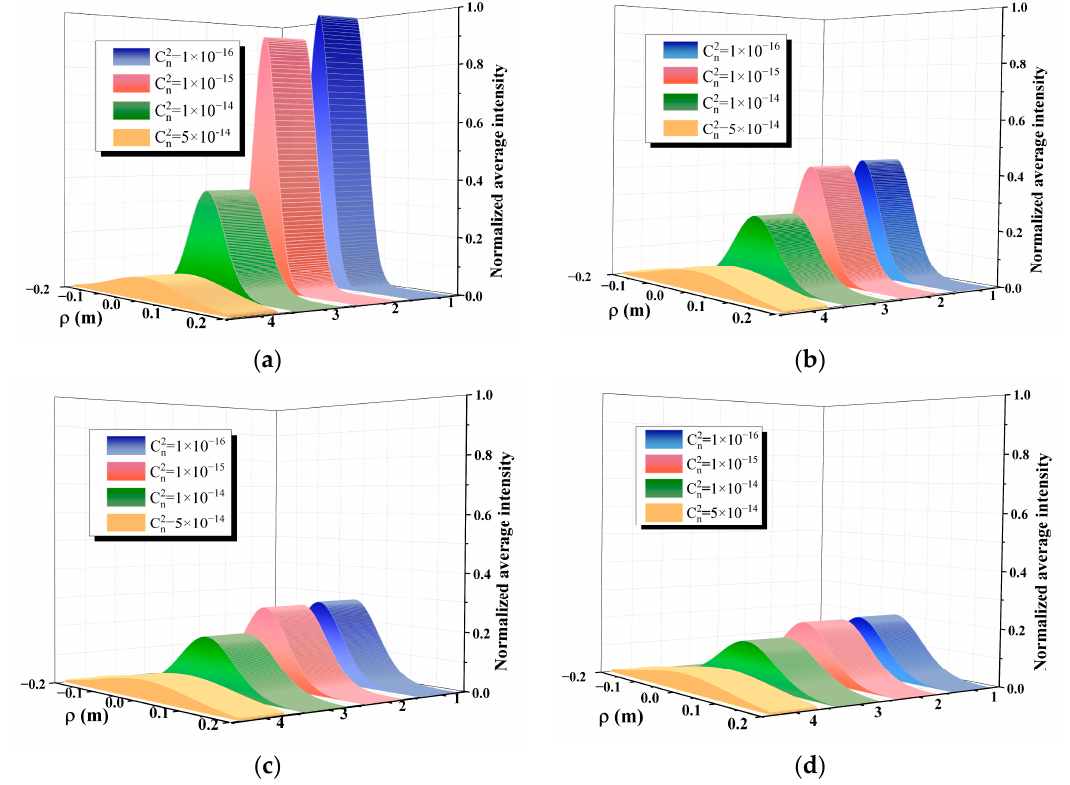
Figure 4. Normalized average intensity distributions of completely coherent light and partially co- herent light at the receiving plane under di ff erent turbulence strengths. The coherence degree  is ( a ) 1; ( b ) 3; ( c ) 5; ( d ) 7. ( a ) 1; ( b ) 3; ( c ) 5; ( d )